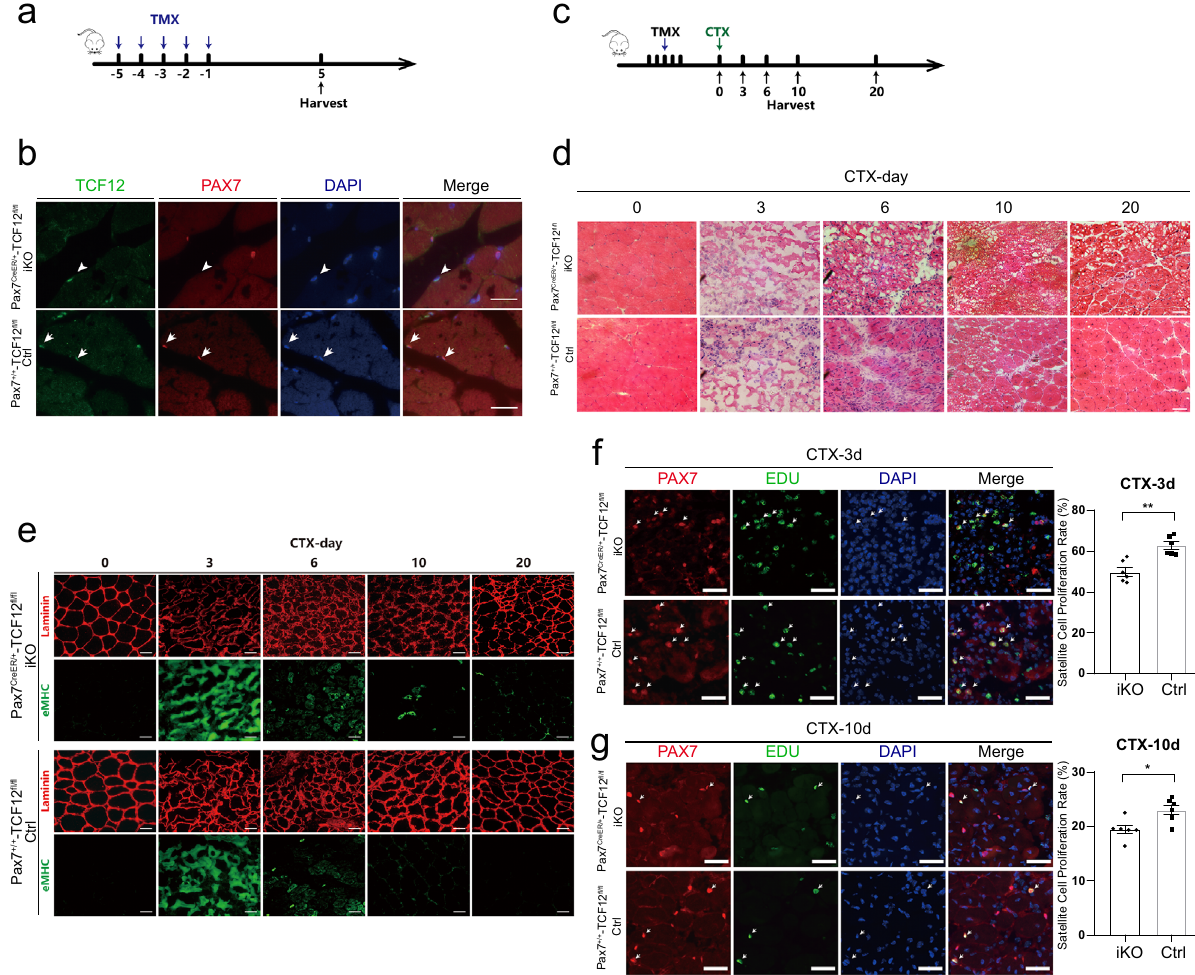
Fig. 2 TCF12 is required for skeletal muscle regeneration. ( a ) Schematic outline of tamoxifen (TMX) administration in the Pax7 CreER/ + -TCF12 fl / fl (TCF12iKO, iKO) or Pax7 + / + -TCF12 fl / fl (Control, Ctrl) mice; ( b ) IF staining for Pax7 and TCF12 on the TA muscles of the TCF12iKO and Ctrl mice; arrowheads point to the Pax7 + /TCF12 + cells and arrows point to the Pax7 − /TCF12 + cells; ( c ) Schematic outline of experimental design for evaluating the effect of TCF12 deletion on cardiotoxin (CTX)-induced muscle regeneration in the TCF12iKO mice; ( d ) H&E staining of the injured TA muscles collected from the designated time points after CTX injection to visualise the degree of regeneration; (e) IF staining for eMHC and laminin in TA muscle after CTX injury in the TCF12iKO and Ctrl mice; ( f , g ) IF staining for Pax7 and EdU on TA muscle 3 and 10 days after CTX injury. Arrows point to the Pax7 + /EdU + cells. Quanti fi cation of EDU-positive MuSCs is shown as the proliferation index on the right ( n = 6); scale bars = 100 μ m. Data are expressed as the mean ± SEM. n.s. not signi fi cant, * P < 0.05, ** P < 0.01, *** P <